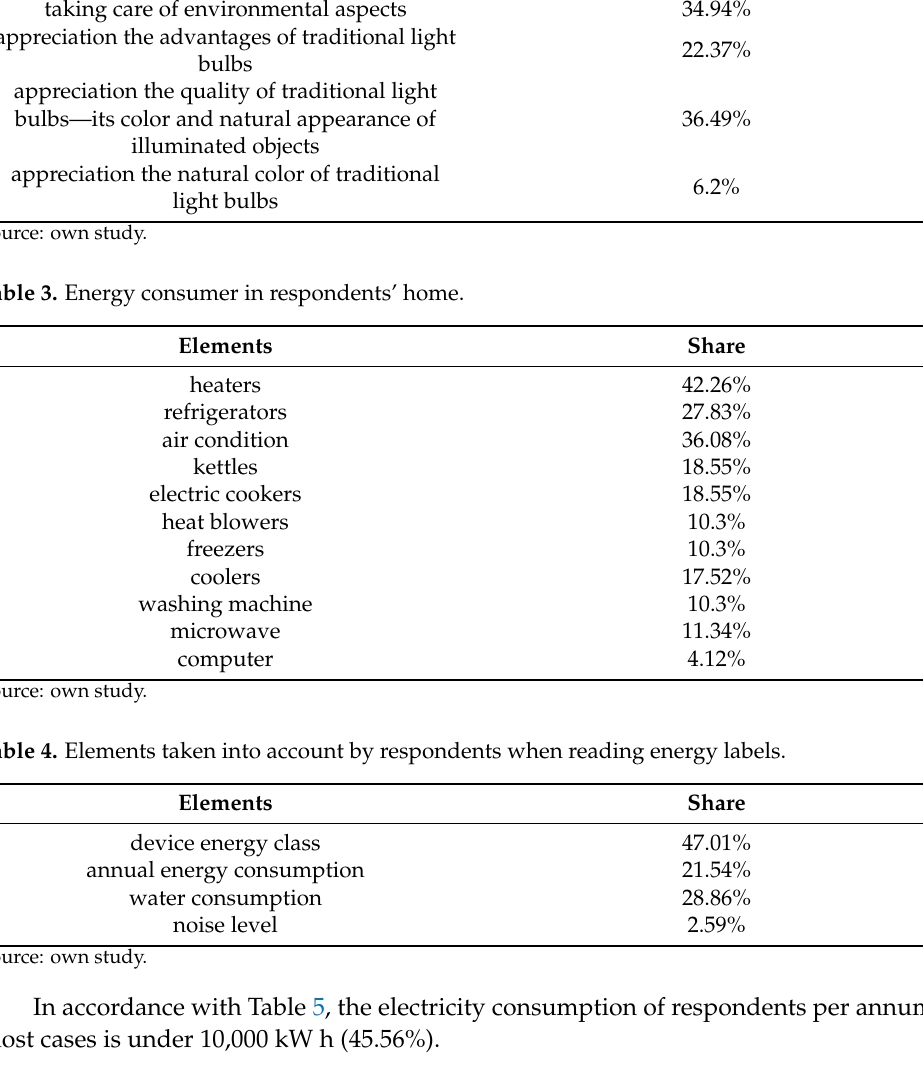
Table 5. Electricity consumption of respondents per